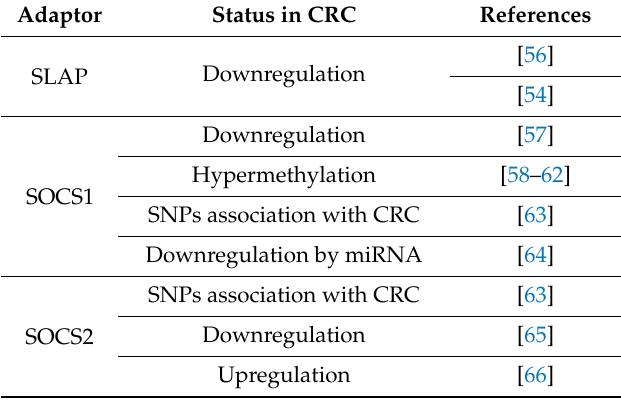
Table 1. Deregulation of SLAP and SOCS proteins in colorectal cancer (CRC) and underlying